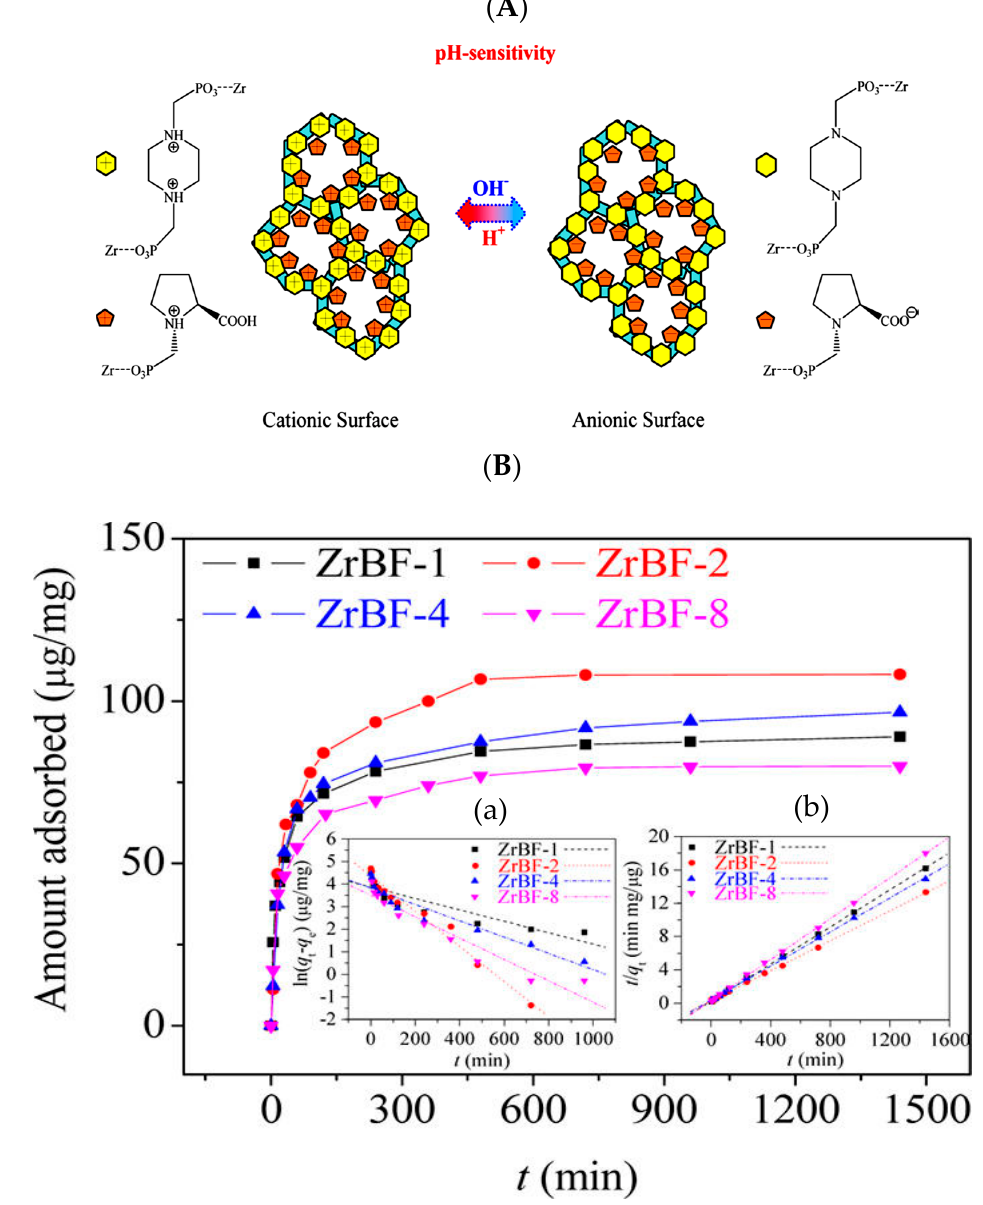
Figure 7. ( A )—illustrative scheme for ZrBF’s biofunctionality, pH sensitivity, and functionalizability; ( B )—adsorption kinetics of ZrBF-n (n = 1, 2, 4 and 8) for DNA. Insets—linear fit according to the pseudo-first order rate equation (a) and pseudo-second order rate equation (b), respectively. Reprinted with permission from [101]. Copyright (2013), American Chemical Society.